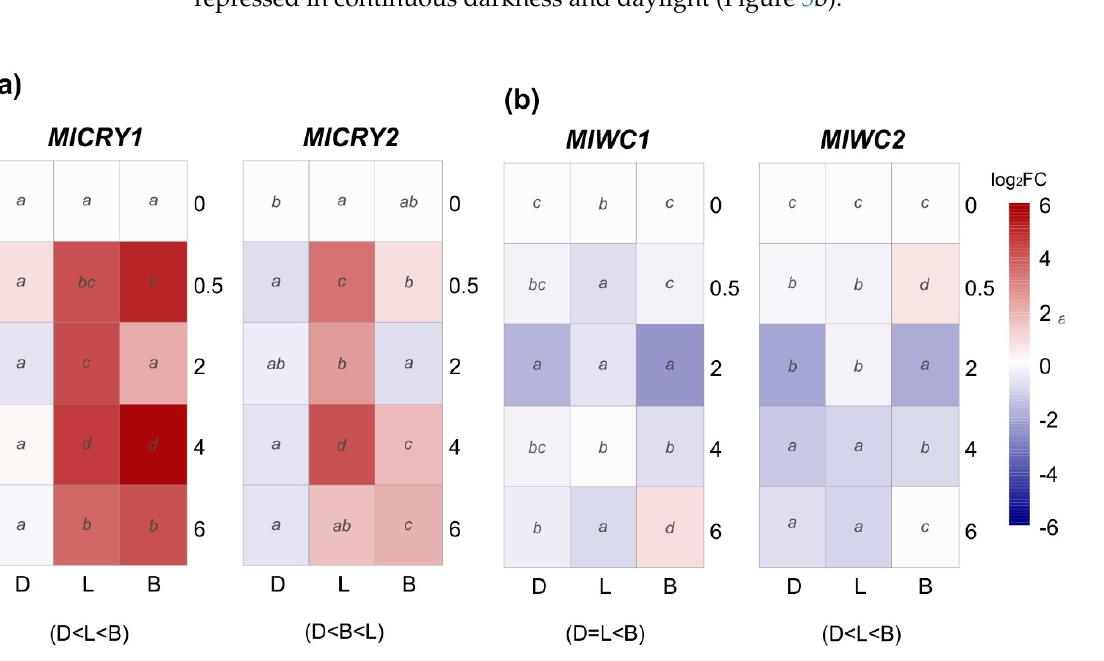
Figure 5. The heat maps represent changes in the relative gene expression of ( a ) two cryptochromes ( CRY ) and ( b ) two white-collar ( WC ) coding genes under continuous darkness (D), daylight (L), or blue (B) light at different time points. The scale is log 2 of fold change mean values after normalization against 0 h post illumination using the 2 − ∆∆ CT method. Red color represents a higher relative expression than 0 h post illumination, and blue color represents a lower relative expression. Data were analyzed between light sources containing all times (shown at the bottom between brackets), and by light source between times (letters) by analysis of variance; the mean values with the same letter are not significantly different ( p ≤ 0.05) according to Duncan’s multiple range tests.